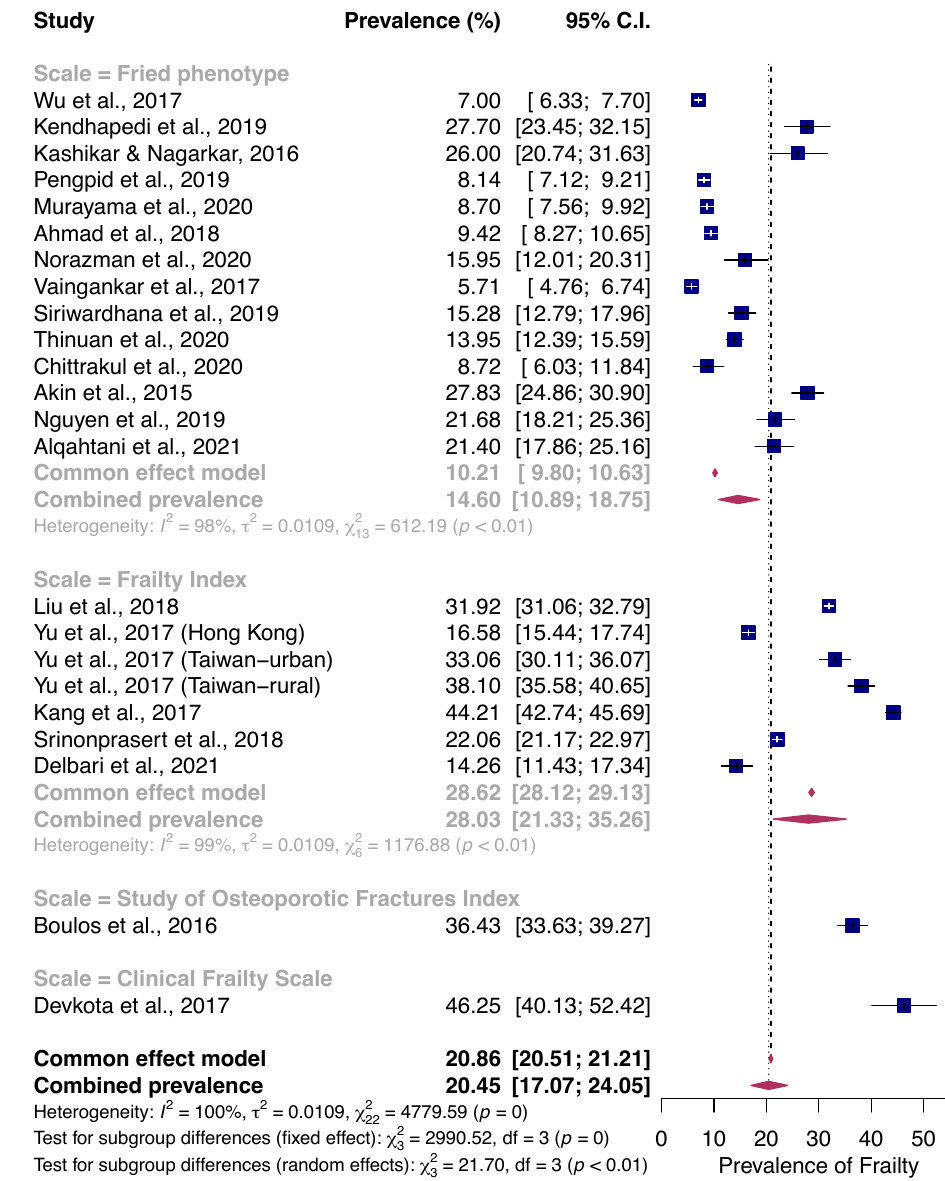
Figure 4. Pooled Prevalence of Frailty stratified by Frailty Assessment Method among community- dwelling older adults.